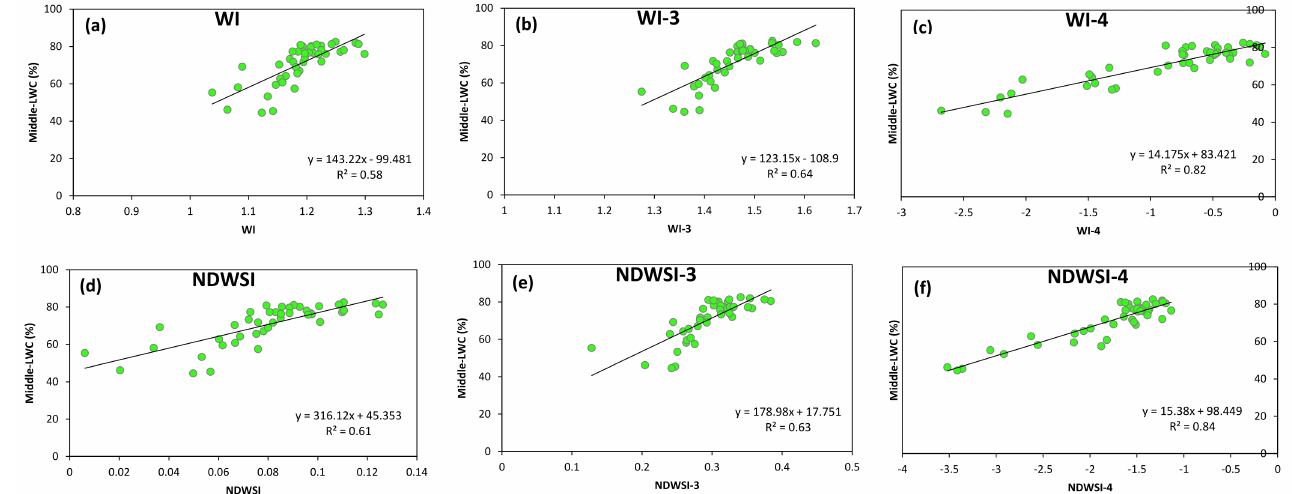
Figure 7. Scattering plots of relationships between the optimal RRD type of indices/the corresponding published spectral indices and the middle-LWC for the entire canopy. Subplots ( a – c ) show the relationships between the WI, WI-3, WI-4 and middle-LWC respectively, subplots ( d – f ) show the relationships between the NDWSI, NDWSI-3, NDWSI-4 and middle-LWC